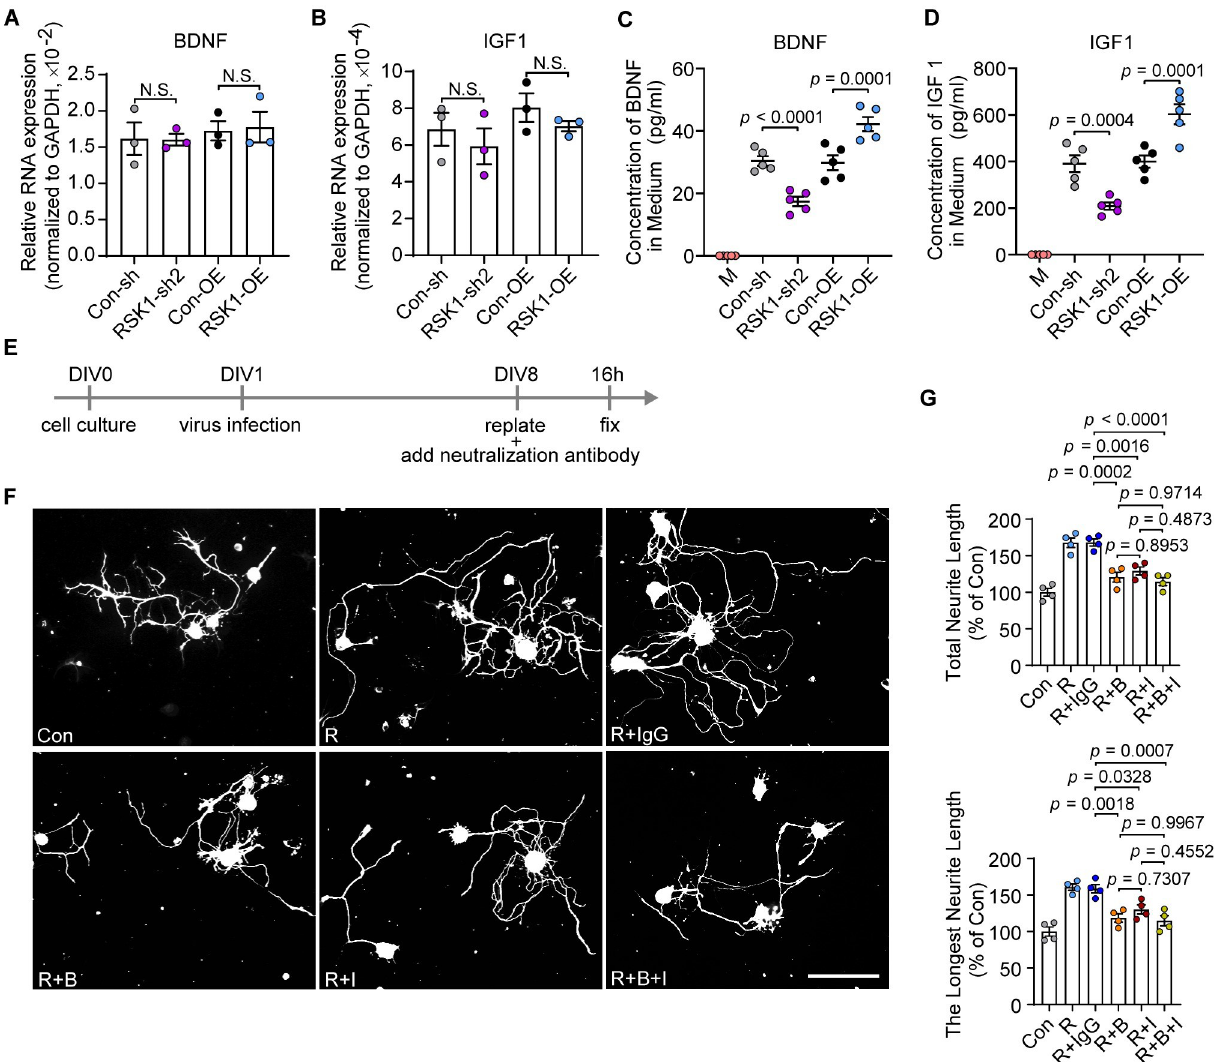
Fig 7. RSK1 promotes axon regeneration through BDNF and IGF1. (A, B) RT-qPCR analysis of the expression of BDNF (A) or IGF1 (B) in neurons infected with AAV expressing control shRNA (Con-sh), RSK1-shRNA2 (RSK1-sh2), RSK1 (RSK1-OE), or empty AAV (Con-OE) for 7 days (N.S., not significant, mean ± SEM, 1-way ANOVA, Bonferroni post hoc test, n = 3 biologically independent experiments). (C, D) Quantification of secreted BDNF (C) or IGF1 (D) levels in the supernatant of neurons without AAV infection (M) or neurons infected with AAV expressing Con-sh, RSK1-sh2, RSK1-OE, or Con-OE for 7 days followed by replating for 16 hours as determined by ELISA (mean ± SEM, 1-way ANOVA, Bonferroni post hoc test, n = 5 biologically independent samples). (E) Timeline for neutralization antibody incubation of DRG neurons infected with RSK1-OE or Con-OE followed by replating. After replating, the neurons infected with AAV-Con-OE were not incubated with any antibody (Con), and the neurons infected with AAV-RSK1-OE were incubated with no antibody (R), antibody IgG (R+IgG), BDNF neutralizing antibody (R+B), IGF1 neutralizing antibody (R+I), or both BDNF and IGF1 neutralizing antibodies (R+B+I). Antibody details can be found in S8 Table. (F) Representative images of DRG neurons treated as in (E). Scale bar, 100 μ m. (G) Quantification of the total and the longest neurite outgrowth per neuron relating to (F) (mean ± SEM, 1-way ANOVA, Tukey post hoc test, n = 4 biologically independent experiments, approximately 50 cells/experiment on average). The data underlying all the graphs shown in the figure are included in S1 Data. DRG, dorsal root ganglion; ELISA, enzyme-linked immunosorbent assay; OE, overexpression; RSK1, ribosomal S6 kinase 1; RT-qPCR, reverse transcription quantitative real-time PCR; SEM, standard error of the